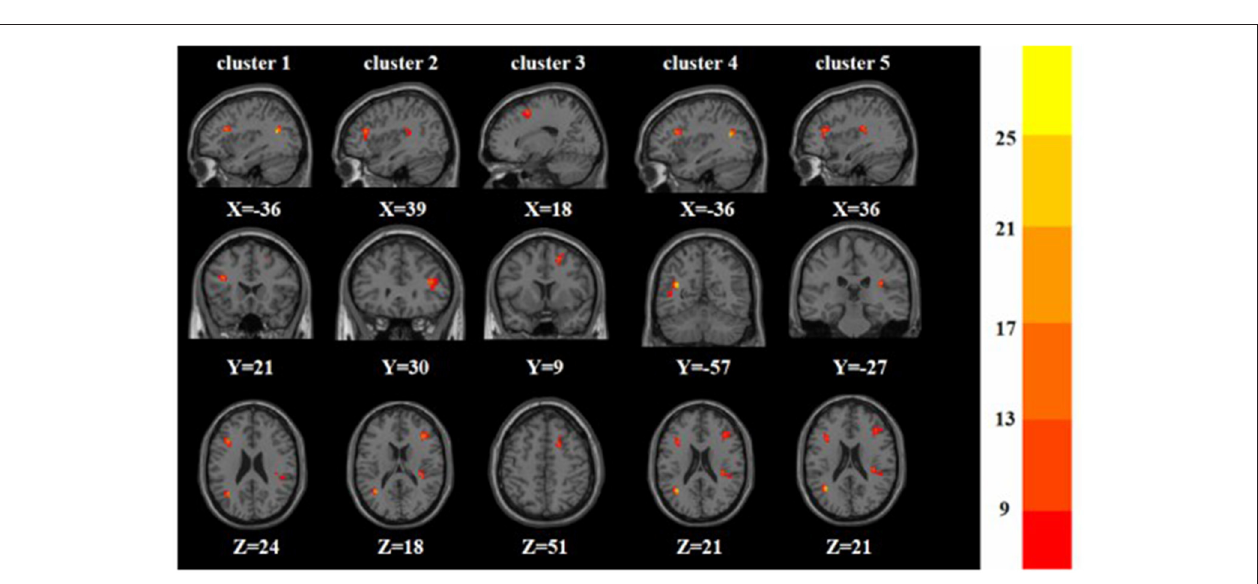
FIGURE 2 | Based on one-way ANOVA for three groups of ReHo abnormal brain regions. The color bars indicate the F